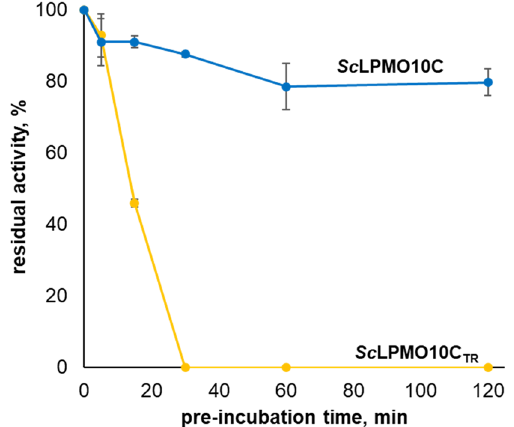
Figure 6. Oxidative stability of Sc LPMO10C and Sc LPMO10C TR . The figure shows the residual activity of 1 µM Sc LPMO10C and 1 µM Sc LPMO10C TR in a reaction with 1% (w/v) Avicel after various periods of pre- incubation with 1 mM ascorbic acid in the absence of substrate (i.e., under conditions that promote auto- catalytic inactivation). The cellulose degradation reaction was carried out for 24 h at 30 °C in 50 mM sodium phosphate buffer, pH 6.0, supplied with fresh 1 mM ascorbic acid. Error bars indicate standard deviations between